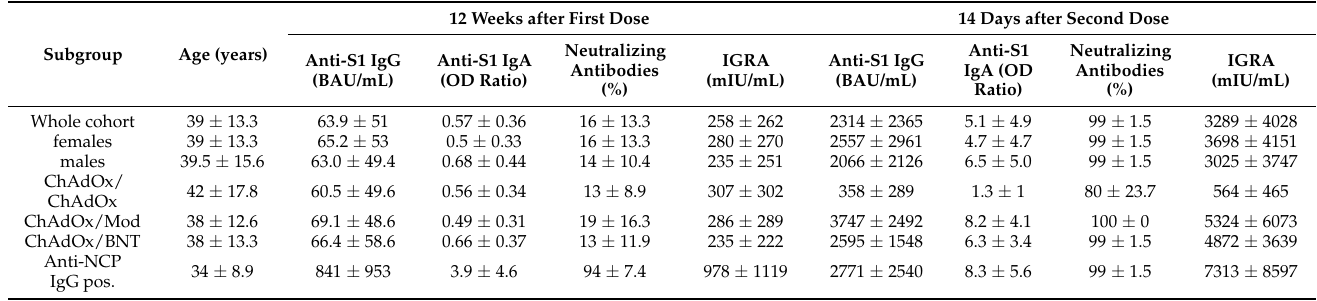
Table 1. Average values (reported via medians ± median absolute deviation) for all measured markers at all time points, including the respective group sizes, for the whole cohort and the following subgroups: women, men, participants having received ChAdOx/ChAdOx, ChAdOx/Mod, ChAdOx/BNT, and participants who have tested anti-NCP IgG positive at the first time point.